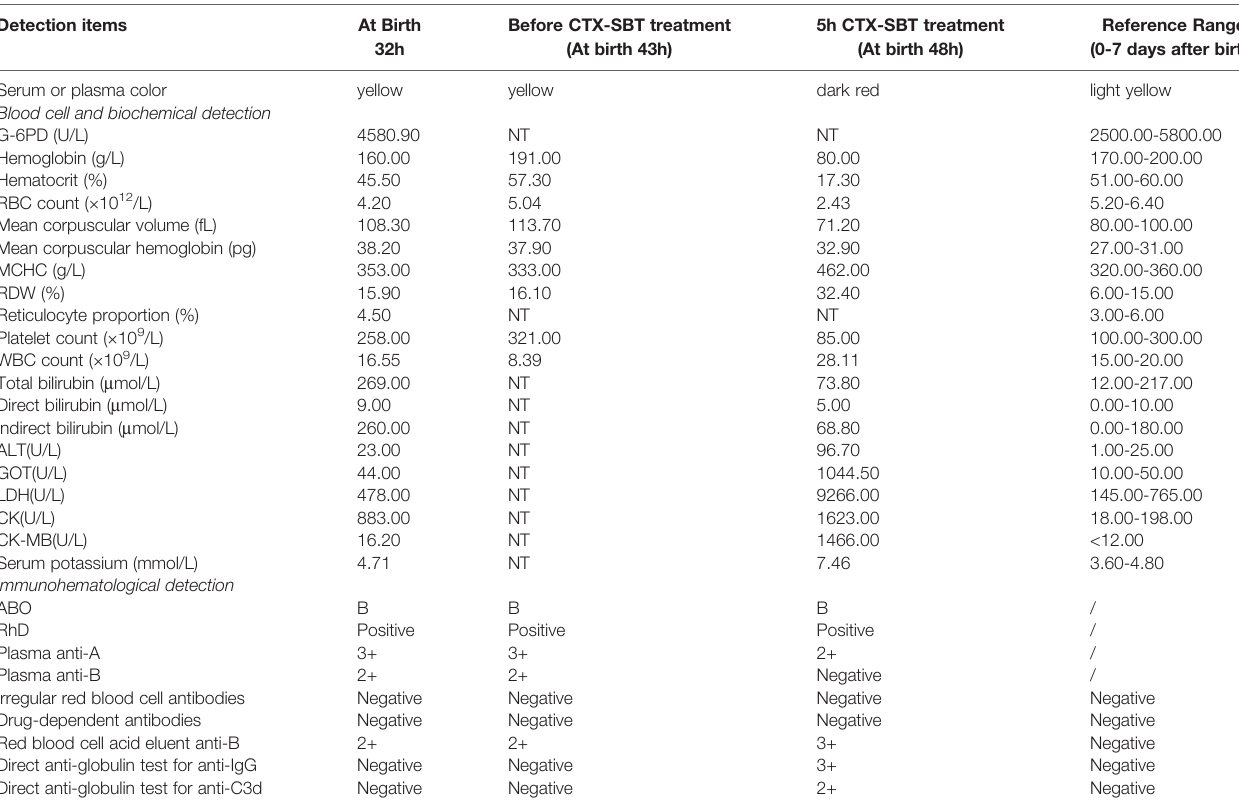
TABLE 1 | Blood indexes changes of the newborn before and after CTX-SBT treatment. Detection items At Birth Before CTX-SBT